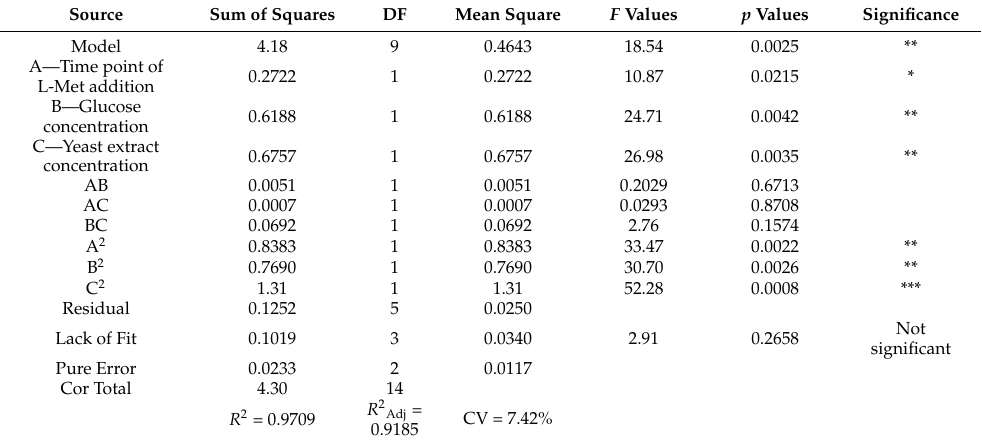
Table 7. Regression coefficients and their significances for 3-Met production from the results of the BBD. Source Sum of Squares DF Mean